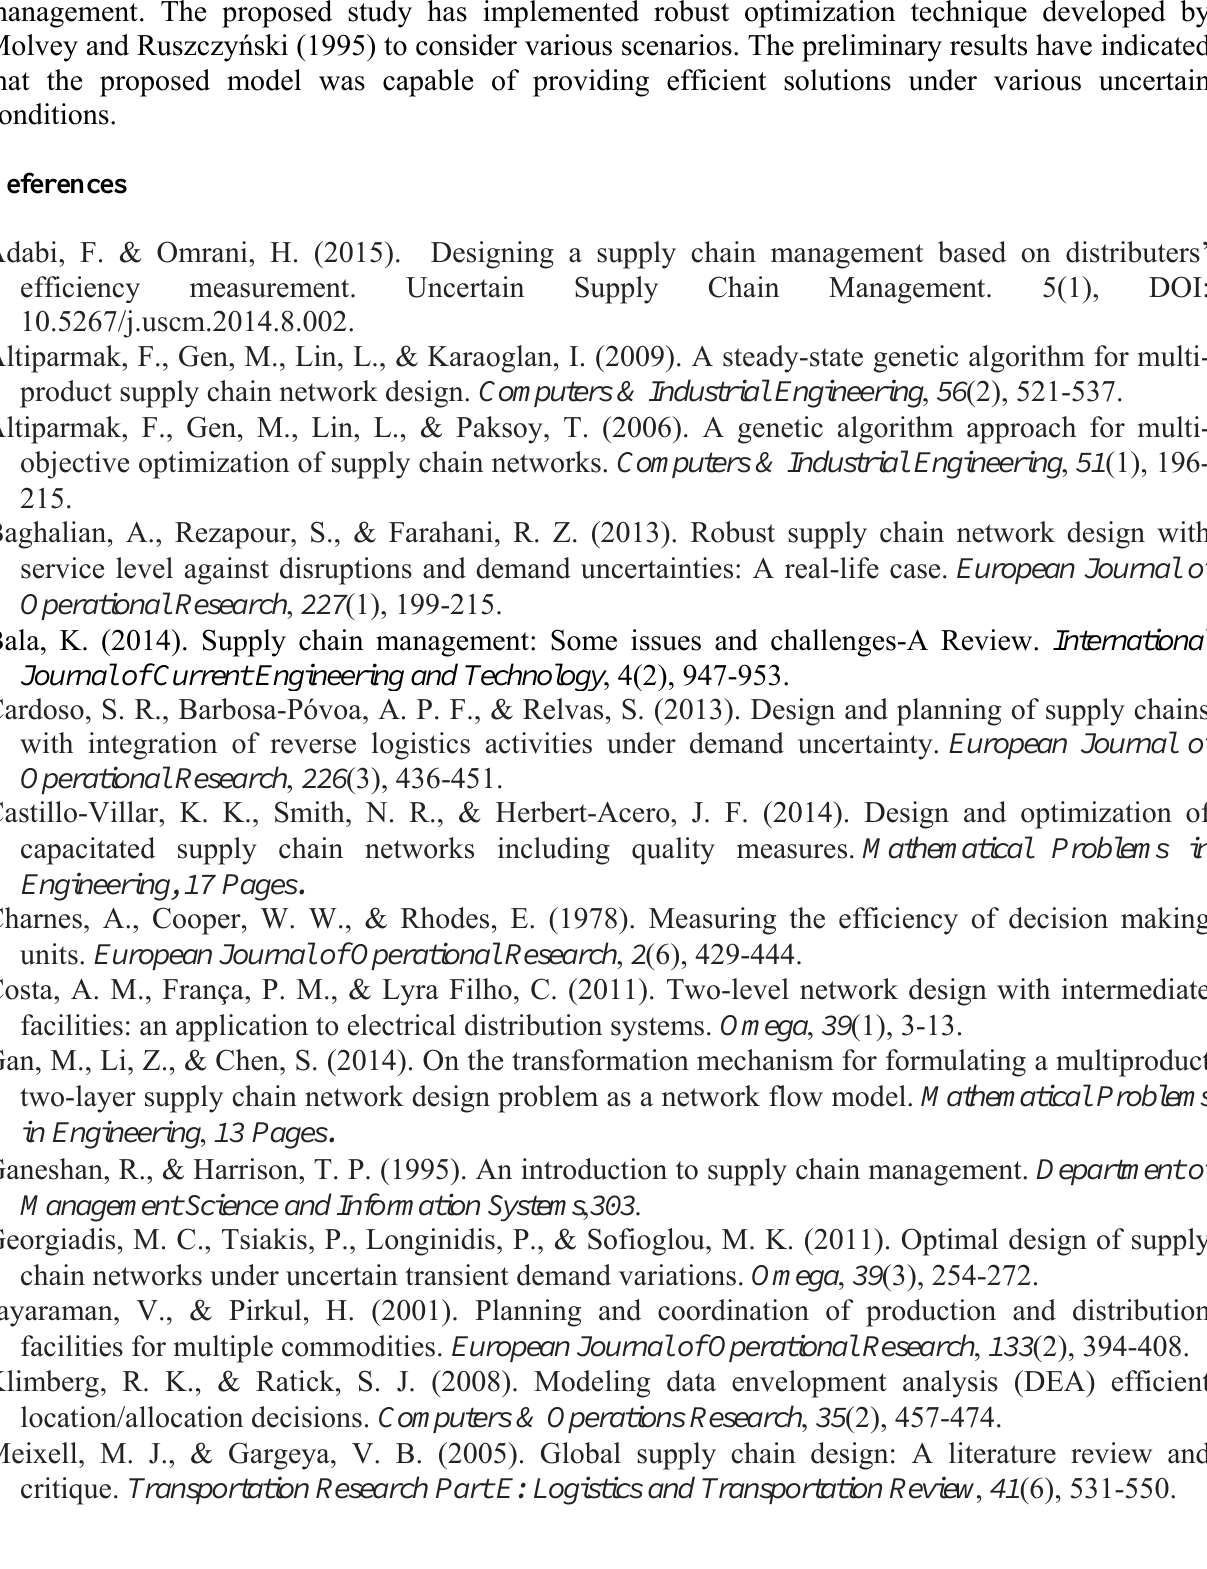
Fig. 1. The position of different locations under uncertain and deterministic